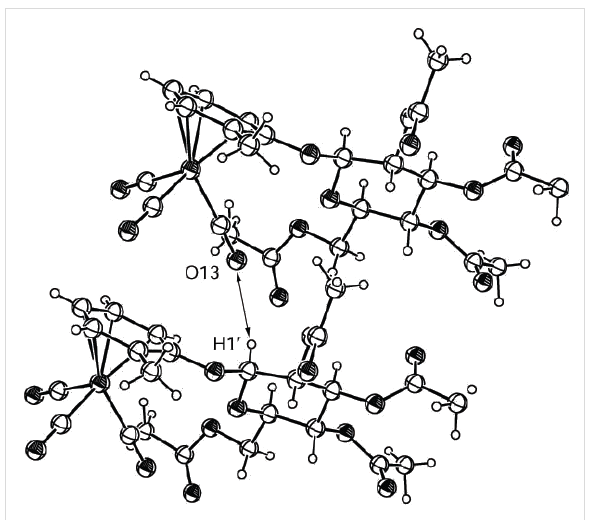
Figure 9 and Figure 10 show the crystal structures of the two diastereomers 2m . The isomer with ( pR )-configuration of the